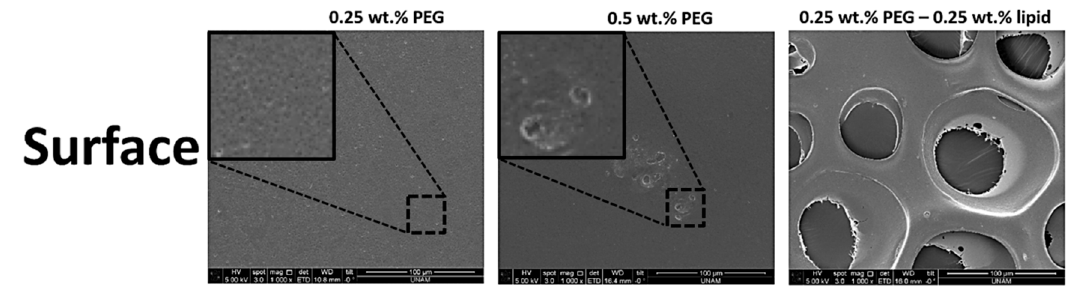
Figure 4. Changes of SEM morphologies of the alginate-based porous film structures formed as a function of PEG-40S (surfactant) and phospholipid concentrations at a constant N 2 gas pressure of 0.8 bar and feeding liquid ′ s flow rate of 100 µl·min − 1 (PEG-40S and phospholipid are denoted by PEG and lipid, respectively). Insets show an enlargement of the porous surface at 0.25% and 0.5% PEG samples, respectively.